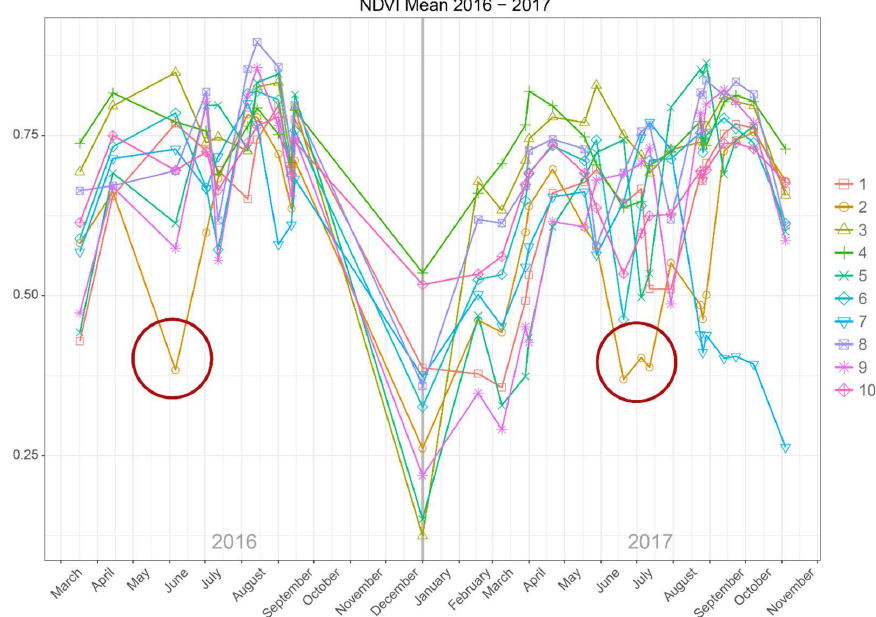
Figure 9. Mean deviations of the selected ten permanent meadows through the years 2016/2017. Falls in NDVI values under the threshold of 0.4 are marked in red.